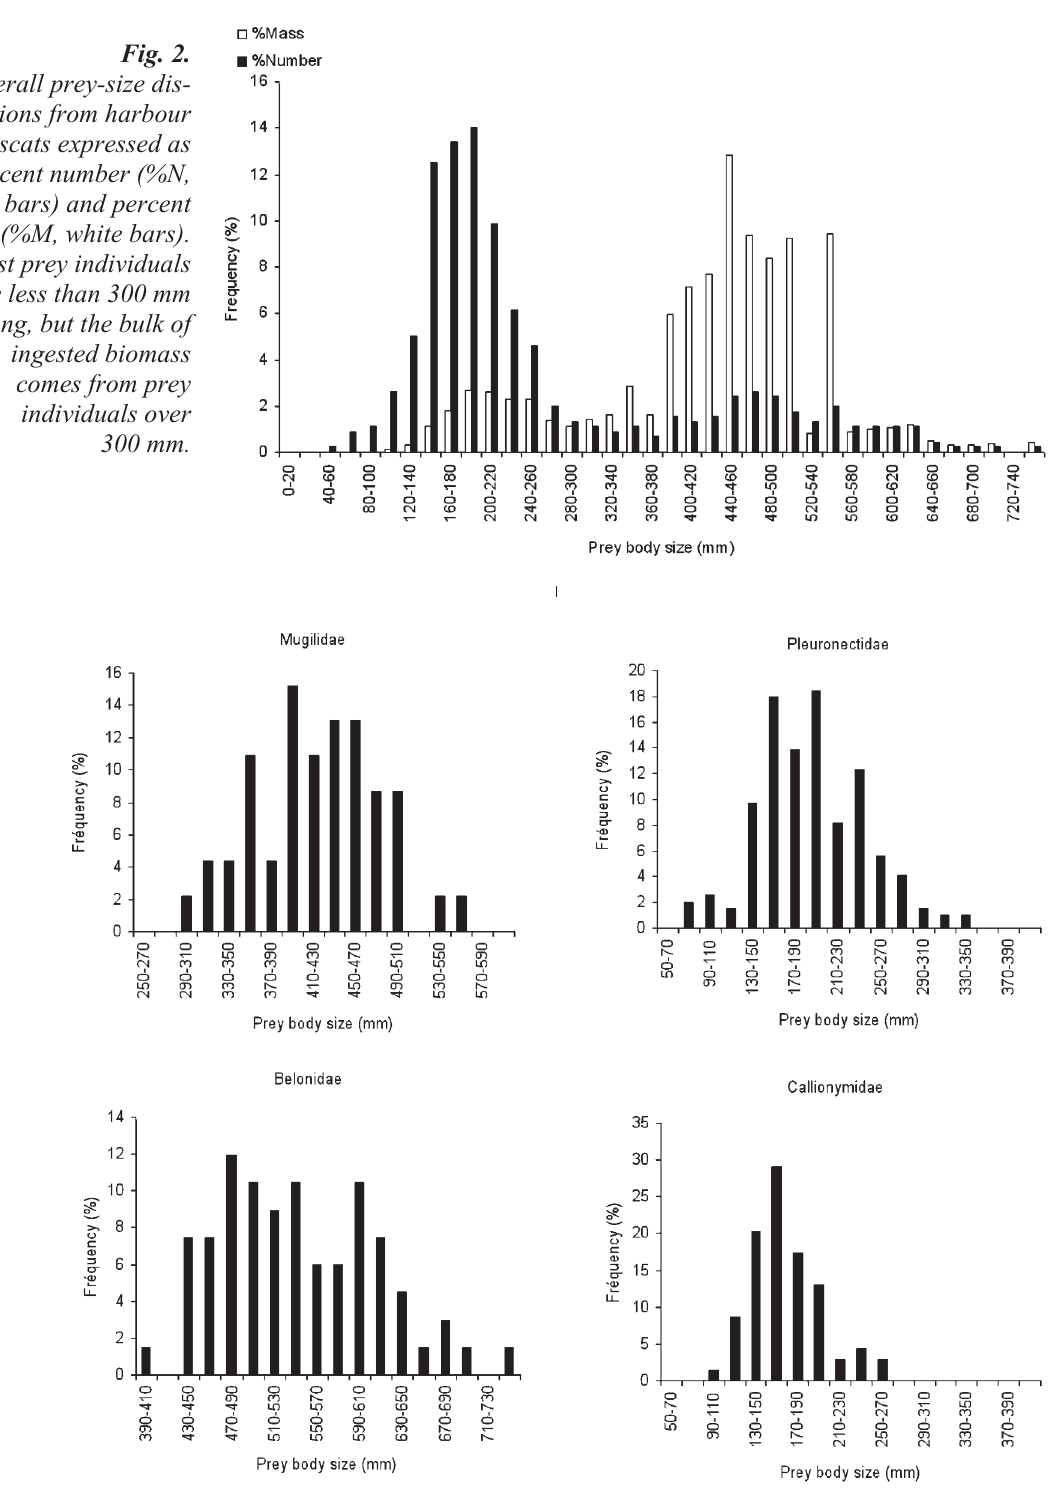
Fig. 3. Body size distributions expressed as percent number for the main prey species identi- fied from harbour seal